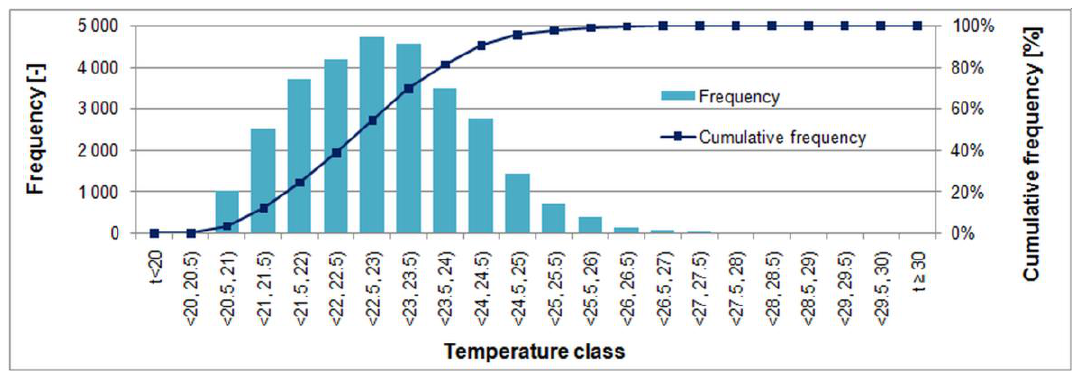
As in the previous case, the maximum temperatures were not observed during the hottest week. The histogram for working hours (Figure 14) showed that temperature within within the range from 20 °C to 25 °C covered 95.5% of all working hours. Extending this the range from 20 ◦ C to 25 ◦ C covered 95.5% of all working hours. Extending this range to range to 26 °C gave 99.1%. 26 ◦ C gave 99.1%.